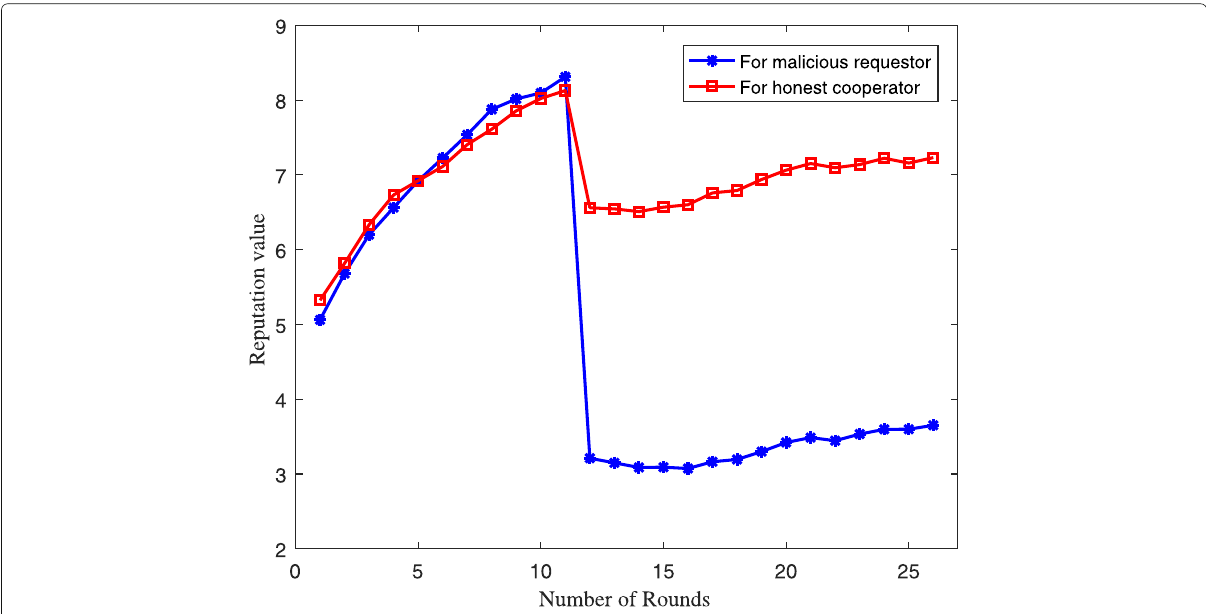
Fig. 7 The reputation of malicious request